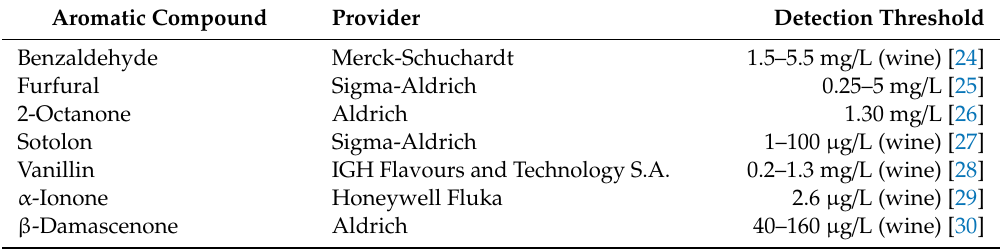
Table 1. Aromatic compounds used and the respective thresholds of perception, for the development of fragrances.